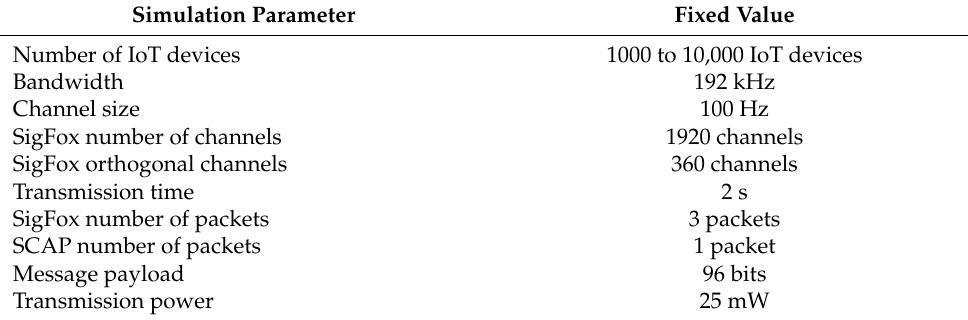
Table 1. Parameter